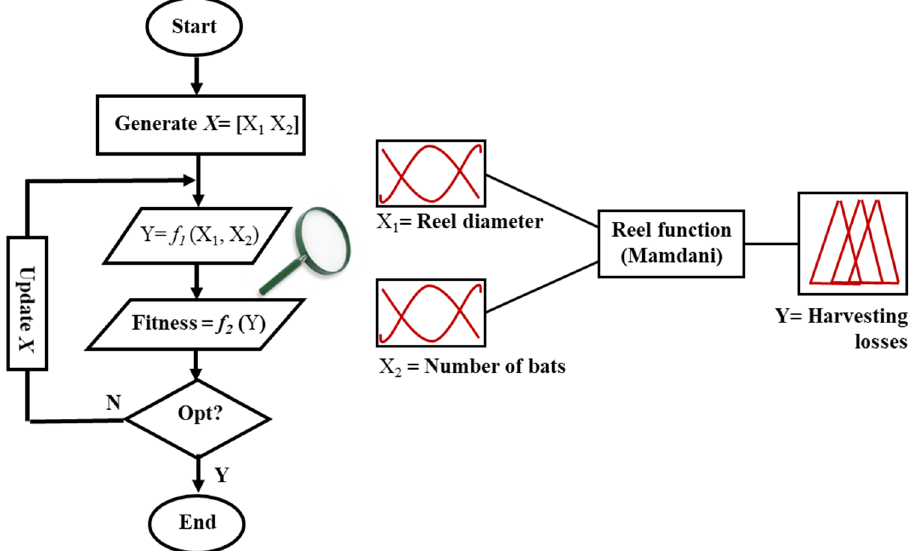
Figure 2. Flowchart representation of the optimization procedure for designing the harvester reel.